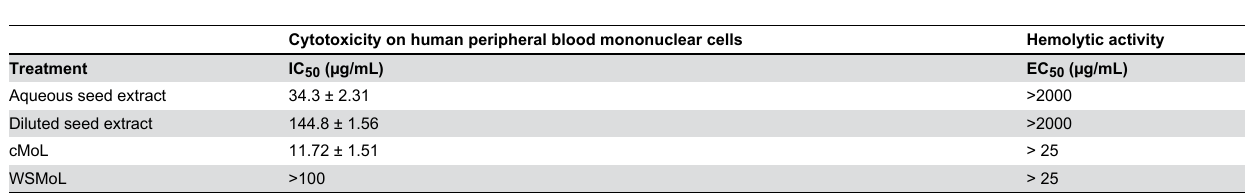
Table 1. Cytotoxicity on human peripheral blood mononuclear cells and hemolytic activity of M. oleifera seed extracts and lectins.